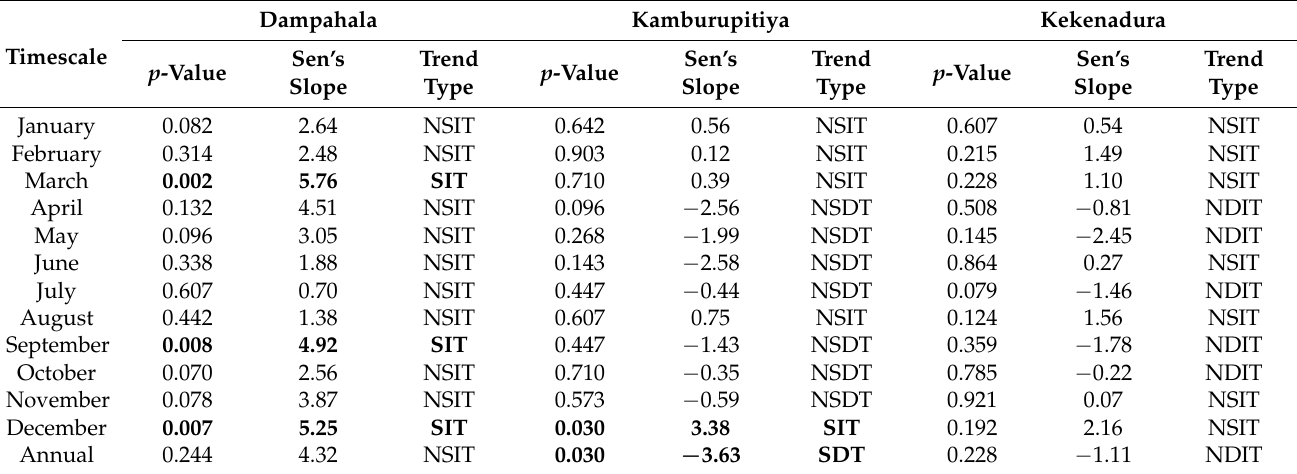
Table 6. Trend analysis results for the extreme rainfall indices